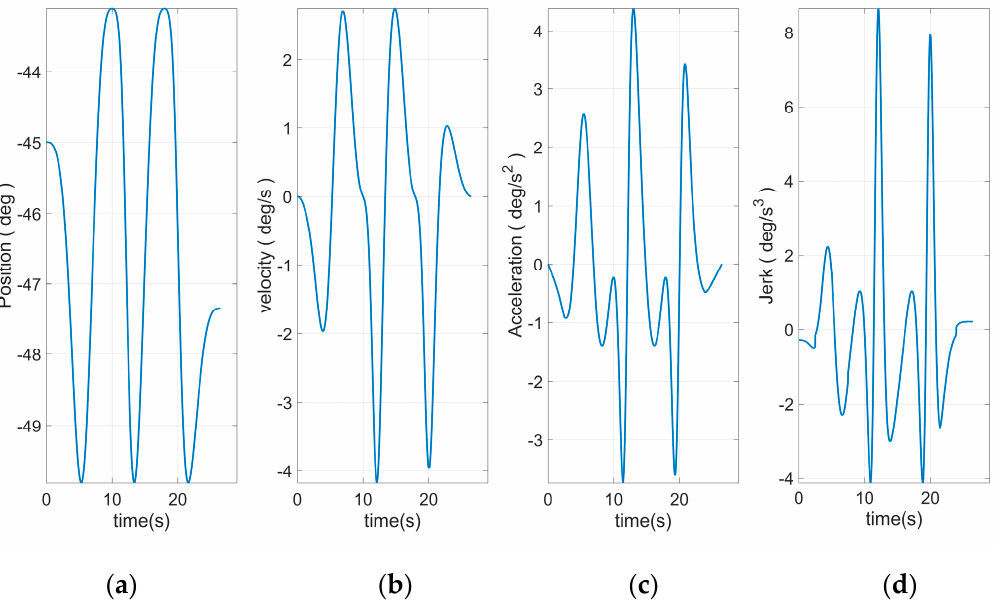
Figure 24. ( a ) Displacement of axis V over time by using seven segments S-curve. ( b ) Velocity of axis V over time by using seven segments S-curve. ( c ) Acceleration of axis V over time by using seven segments S-curve. ( d ) Jerk of axis V over time by using seven segments S-curve.